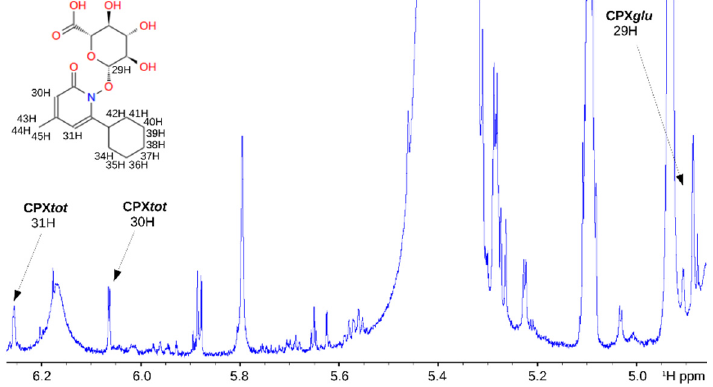
Figure 2. 1 H-1D-NMR spectrum of processed mouse serum resuspended in DMSO-d6 where the assignments of the CPX signals are also shown. CPX glu molecule is represented with proton as-signment.